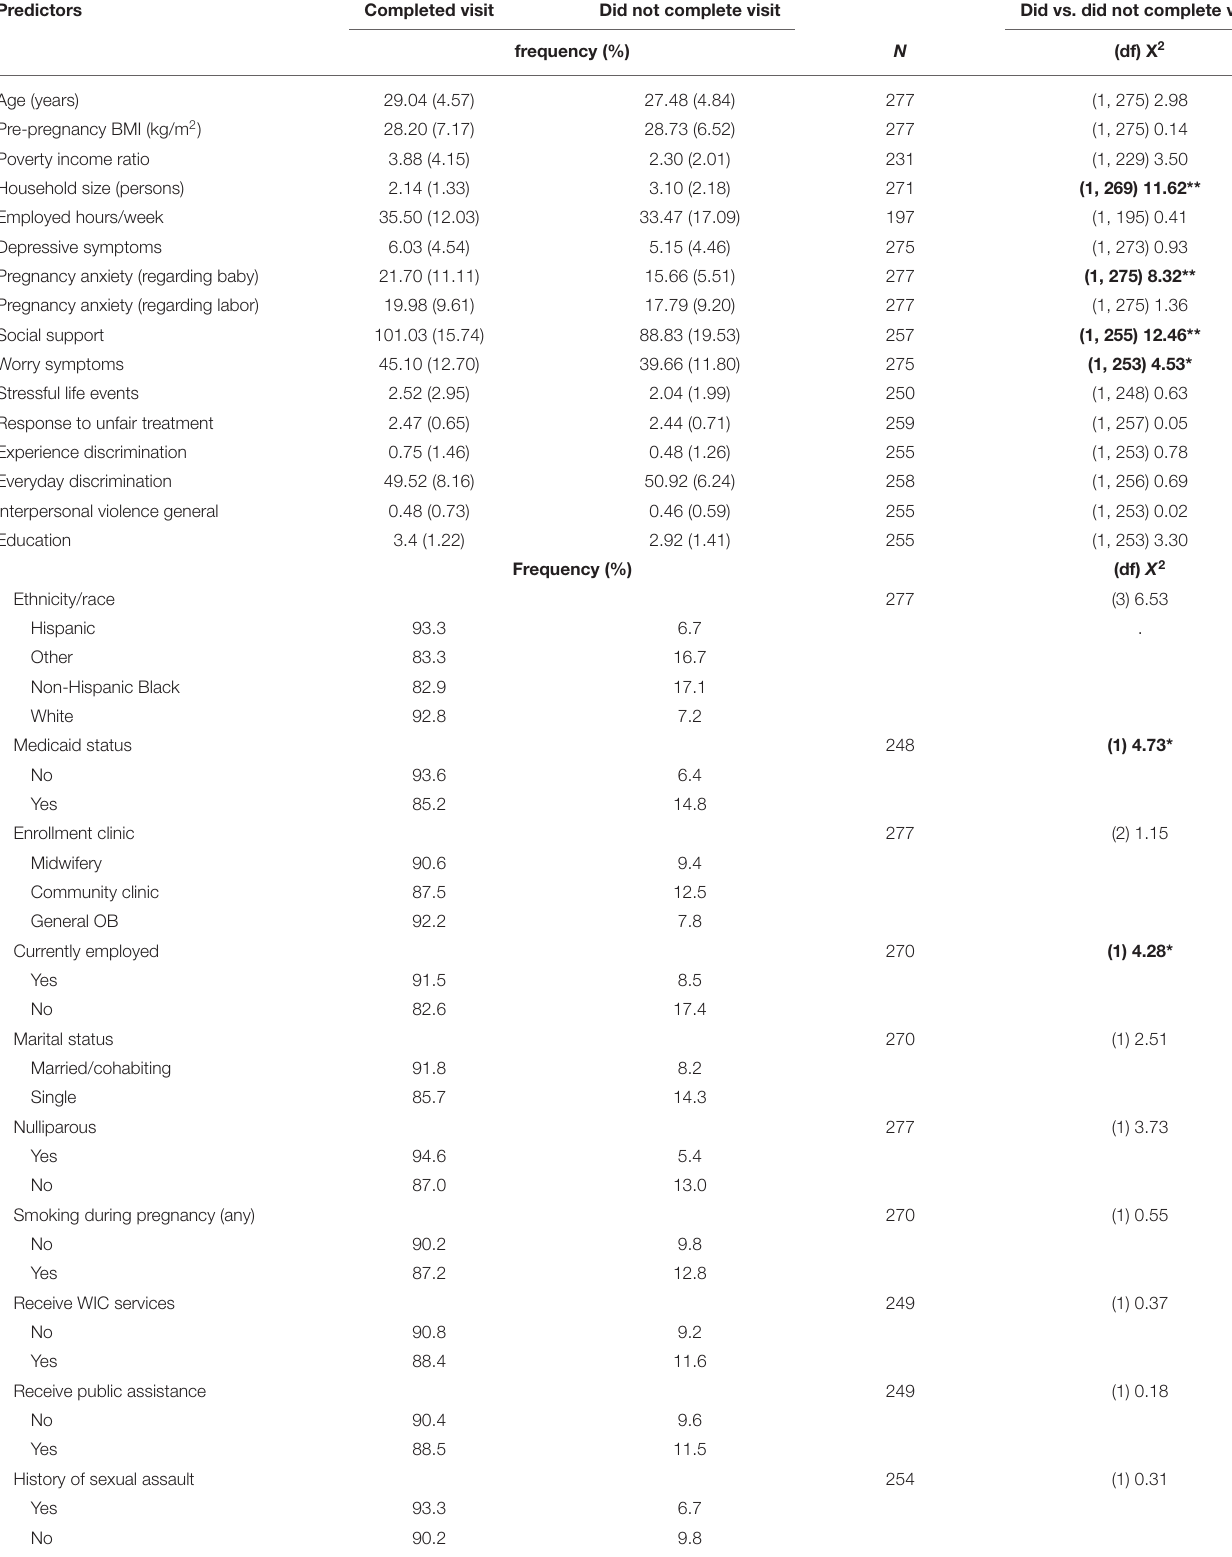
TABLE 4 | Bivariate logistic regression analysis predicting completion of postpartum